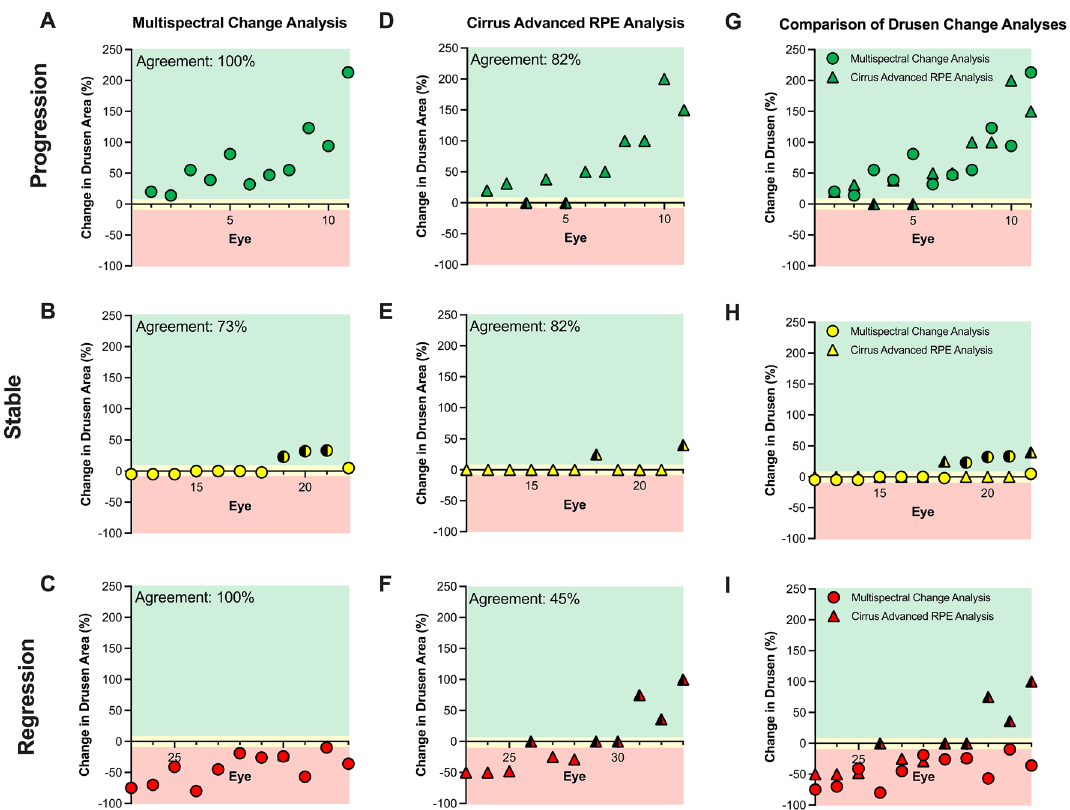
Figure 4. The change in drusen area as assessed using ( A - C ) Multispectral pattern recognition change analysis or ( D – F ) Cirrus Advanced RPE Analysis. For direct comparison of measurements on the same eye, data from both analyses are also displayed together ( G – I ). Data is grouped based on drusen change classification by expert graders: progression ( A , D , G ), stable ( B , E , H ) and regression ( C , F , I ). The background of the plots are shaded green, yellow, and red to correspond to areas classified as progression (> 5% change in drusen area), stable (-5% to 5%) and regression (> -5% change) respectively. False positives/negatives are marked by data points half colored in